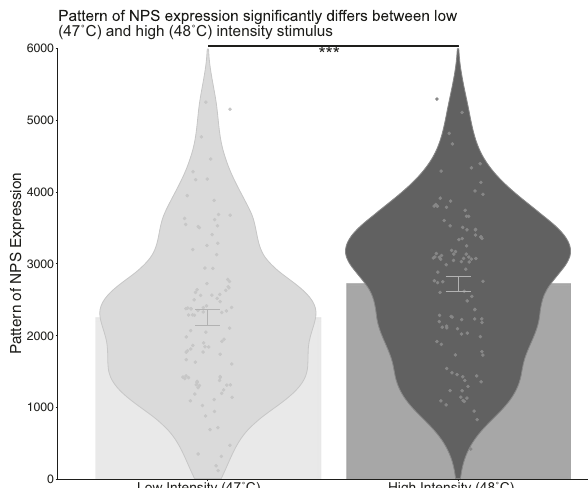
Fig. 6 NPS expression signi fi cantly differs between low (47 °C) and high (48 °C) intensity heat stimuli, as shown by a two-sided paired sample t - test ( p = 1.021 e − 08 ). The average NPS expression, represented by the bars, is higher in high intensity heat stimulation compared to low intensity heat stimulation. In addition, the violin plots, which represent the distribution of individual NPS expression in each intensity, show a greater density of individuals with higher NPS expression in the high intensity heat stimulation than in the low intensity heat stimulation. Finally, the error bars represent one standard error of the mean. *** represents p values< 0.001. n = 101 participants. Source data are provided as an xlsx Source Data fi